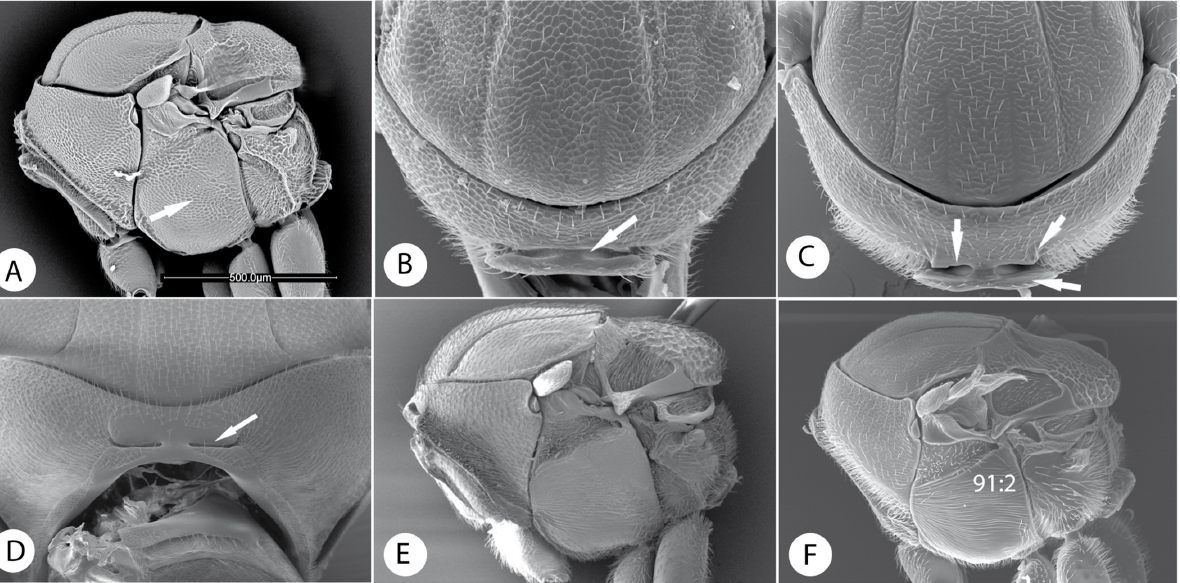
Fig 16. Mesosomal characters of Phanacidini, Aulacideini and Aylacini. A) Mesosoma in lateral view of Phanacis zwoelferi Nieves-Aldrey. B) pronotum in anterior view of Phanacis caulicola (Hedicke). C) of Aulacidea martae Nieves-Aldrey. D) of Barbotinia oraniensis (Barbotin). E) Mesosoma in lateral view of Aylax papaveris . F) of Aulacidea martae .